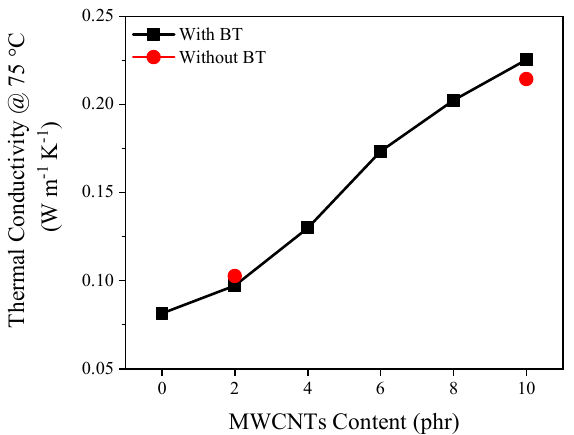
Figure 8. Thermal conductivity of cellular BT / MWCNTs and MWCNTs nanocomposites as a function of MWCNTs loading at 25 °C.